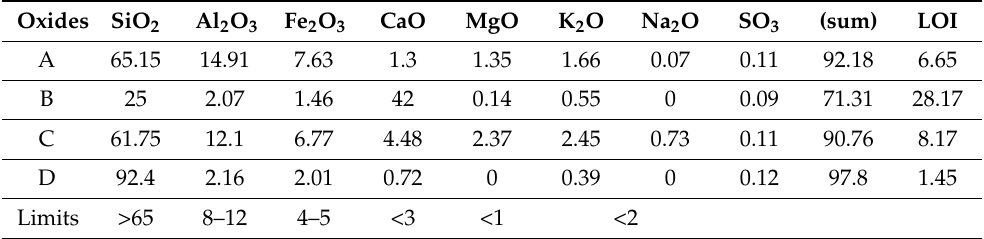
Table 3. Distribution of oxides from selected